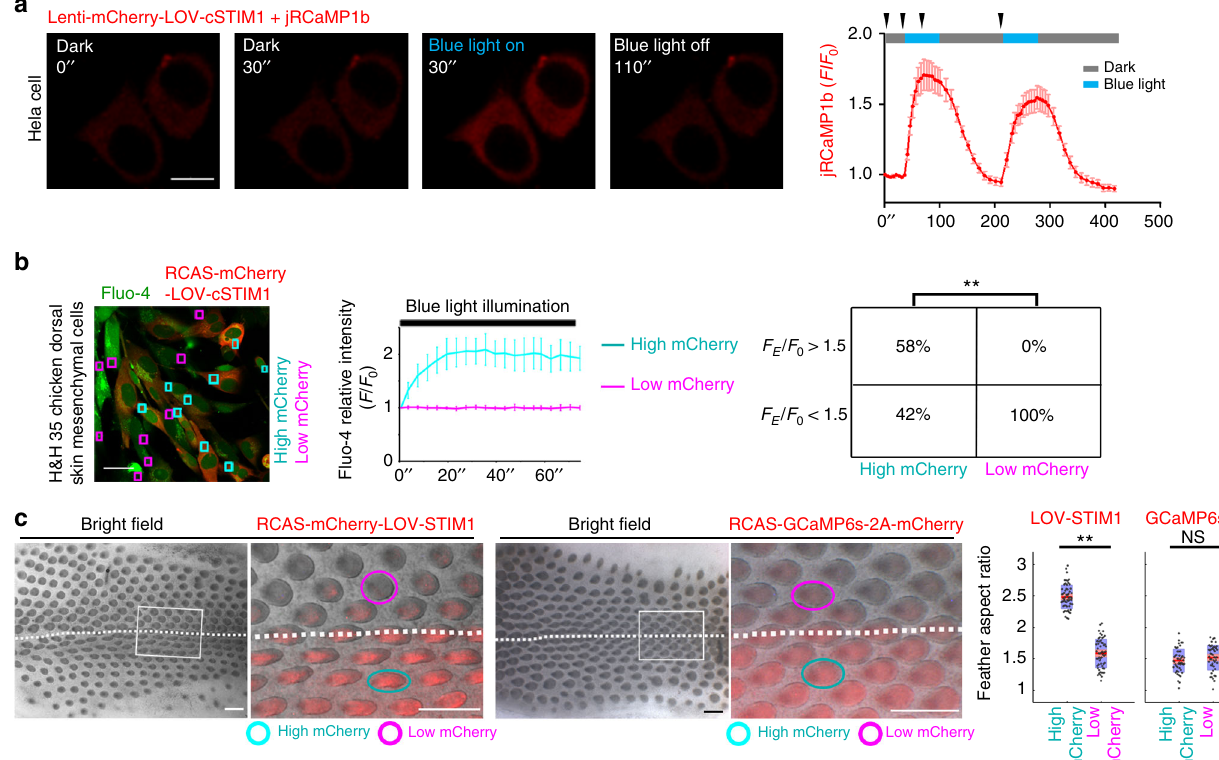
Fig. 4 Ca 2 + in fl ux induced by cyclic activation of opto-cCRAC enhances feather elongation. a In Hela cells opt-cCRAC induced Ca 2 + in fl ux after blue light exposure ( n = 20/20). jRCaMP1b was expressed to detect Ca 2 + level changes. Arrowheads in the line plot highlight the time point of images on the left. F/ F fl uorescence. Mean ± s.d. Scale bar, 10 µ m. b Light-induced Ca 2 + in fl ux occurred in H&H 35 mesenchymal cells infected by virus encoding 0 , changes in opto-cCRAC (cyan rectangles, n = 25/43) but not in the uninfected cells (magenta rectangles, n = 0/33). Mean± s.d. Scale bar, 10 µ m. ( ′′ denotes seconds). F E : fl uorescence at the end of recording (70 ′′ ); ** P < 0.01 (Chi-square test). c After 48 h cyclic blue light illumination, skin regions ( n = 8/10) highly expressing opto-cCRAC developed more elongated feathers than the poorly infected buds ( n = 60 for each group, ** P < 0.01, Wilcoxon rank test). No discernable feather morphology changes ( n = 48, NS, not signi fi cant, Wilcoxon rank test) were observed in skins infected by RCAS-GCaMP6s-T2A- mCherry. Regions close to the dorsal mid-line were magni fi ed (rectangles) to compare feather aspect ratio (ellipses). Scale bar, 500 µ m. Customized boxplot: Mean (red) ± s.d. (pink), 95% con fi dence interval (violet). Dots denote individual data